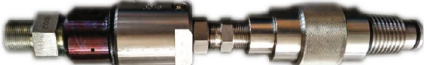
Figure 10: Schematic diagram of hydraulic slotted shallow helix integral drill pipe.